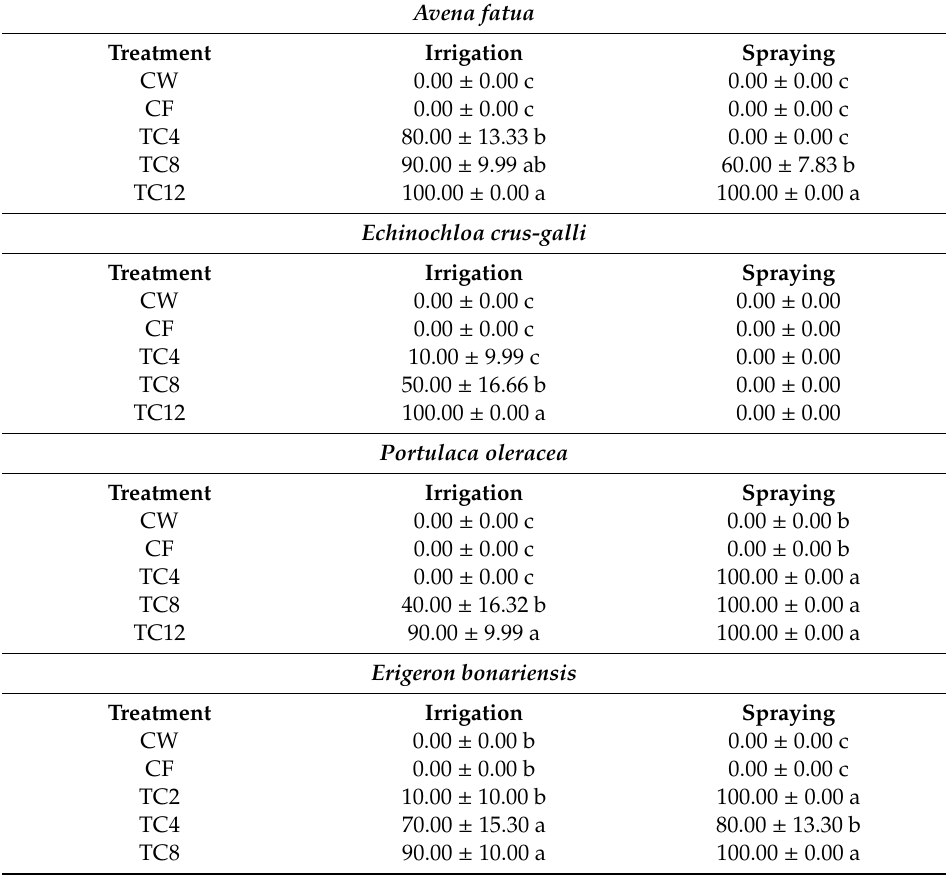
Table 11. E ffi cacy of TC4 on target weed species A. fatua , E. crus-galli , E. bonariensis and P.